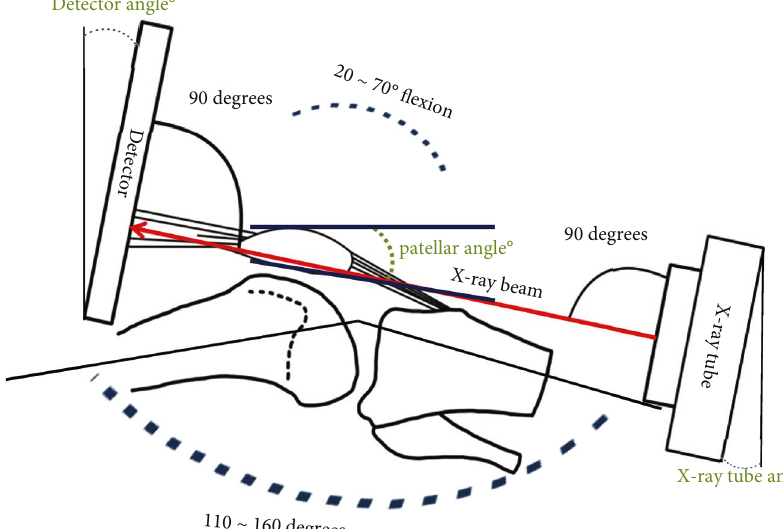
Figure 2: Set the X-ray tube and detector angles to be perpendicular to the angle of the patella.